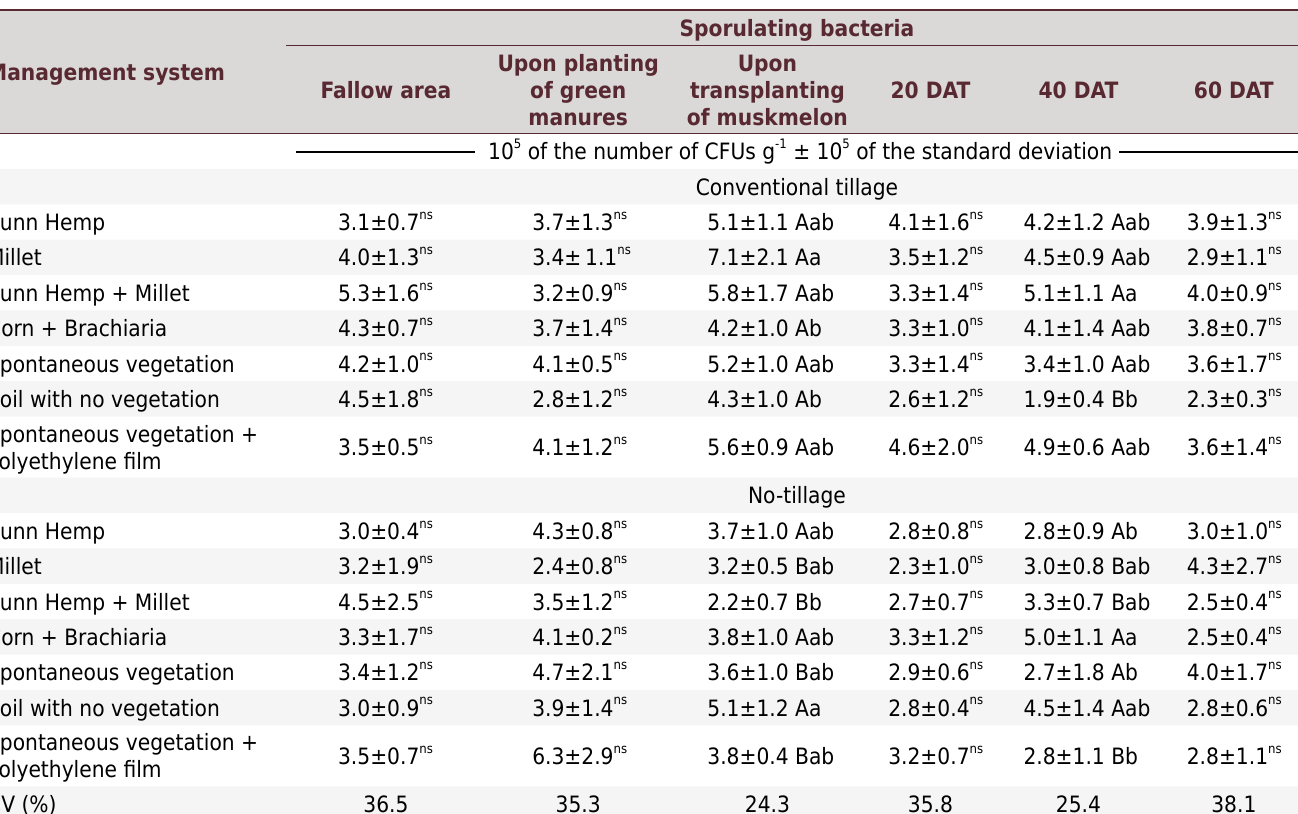
Table 2. Number of colony forming units (CFUs) of sporulating bacteria in the no-tillage and in the conventional tillage systems in different management systems and soil sampling times.